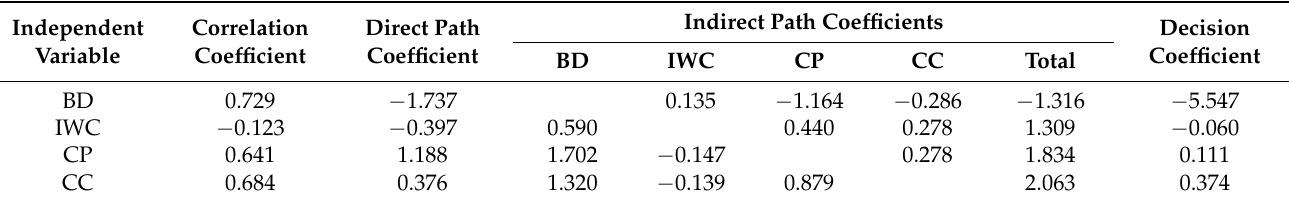
Table 6. Path coefficient between environmental factors and soil IIR.